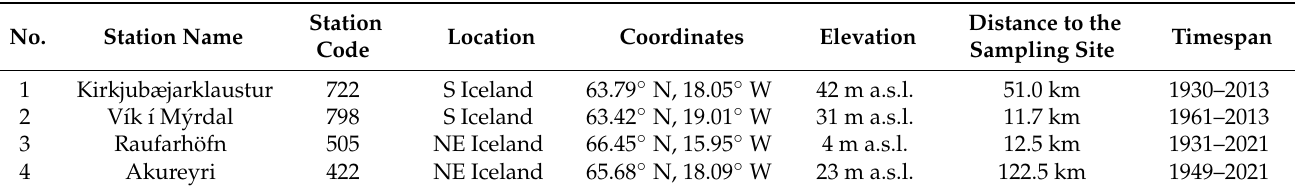
Table 1. General information on selected long-term climatological data (mean monthly temperature and monthly precipitation totals) used in the studies.